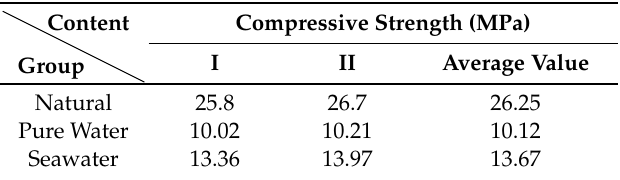
Table 2. The uniaxial compressive strength of the soft rock in three states.